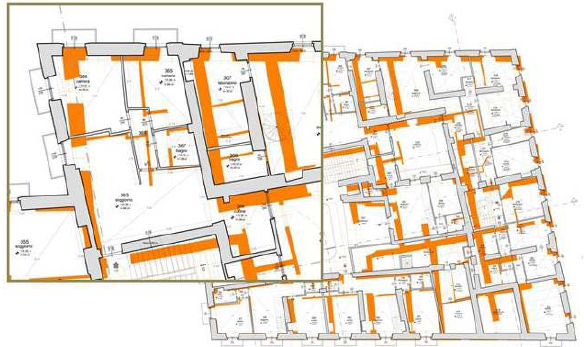
Figure 13. 2D drawings: planimetric comparison with the previous traditional survey (software: Autocad).